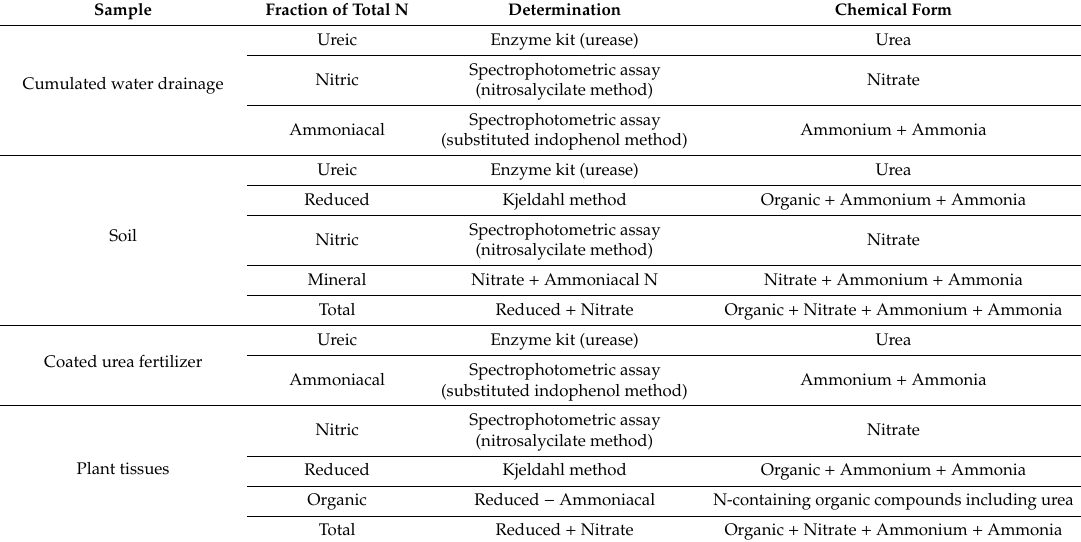
Table 3. Analytical assays used to determine nitrogen concentration in samples of water, soil, coated urea fertilizer and plant tissues in the three